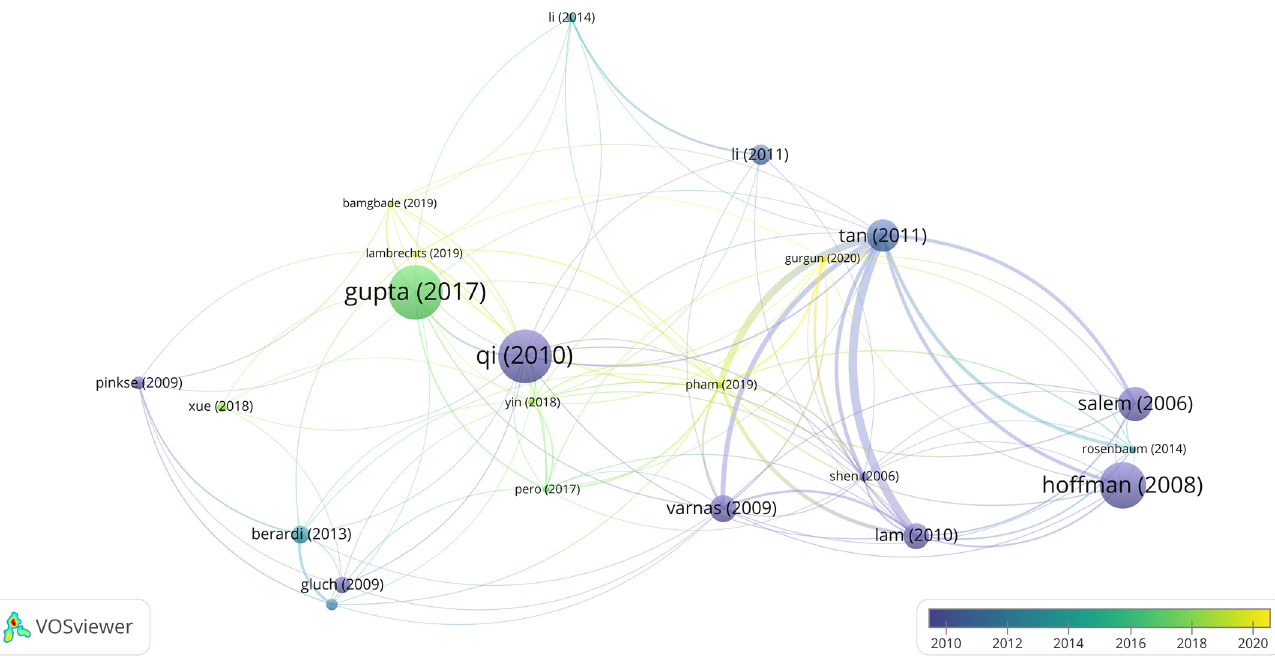
Figure 8. Map of the in fl uential publications and co-citation by year.